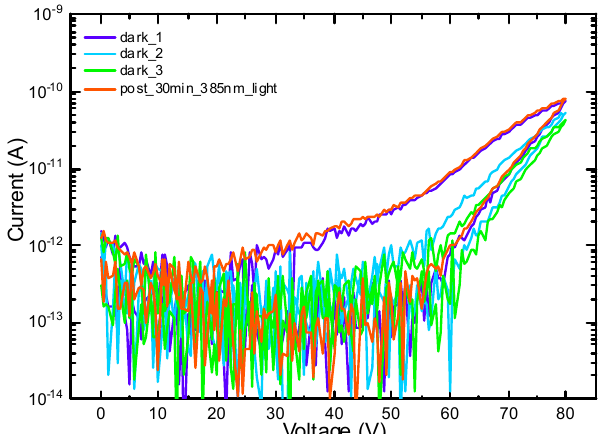
Figure 9. Double sweep current–voltage characterization on structure B, first, second, and third I–V on a fresh sample, then after 30 min irradiation with an LED light at a wavelength of 385 nm.